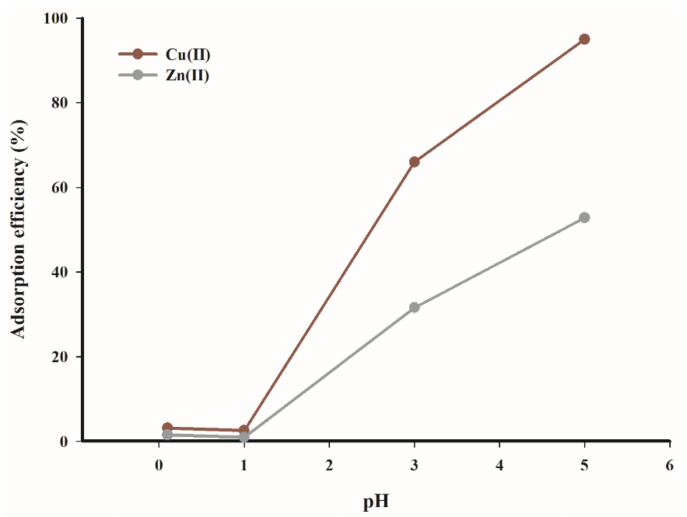
Figure 7. Effect of pH on the adsorption efficiency (T = 298.15 K, t = 240 min, c = 100 mg · dm − 3 , mass of adsorbent = 3.33 g · dm − 3